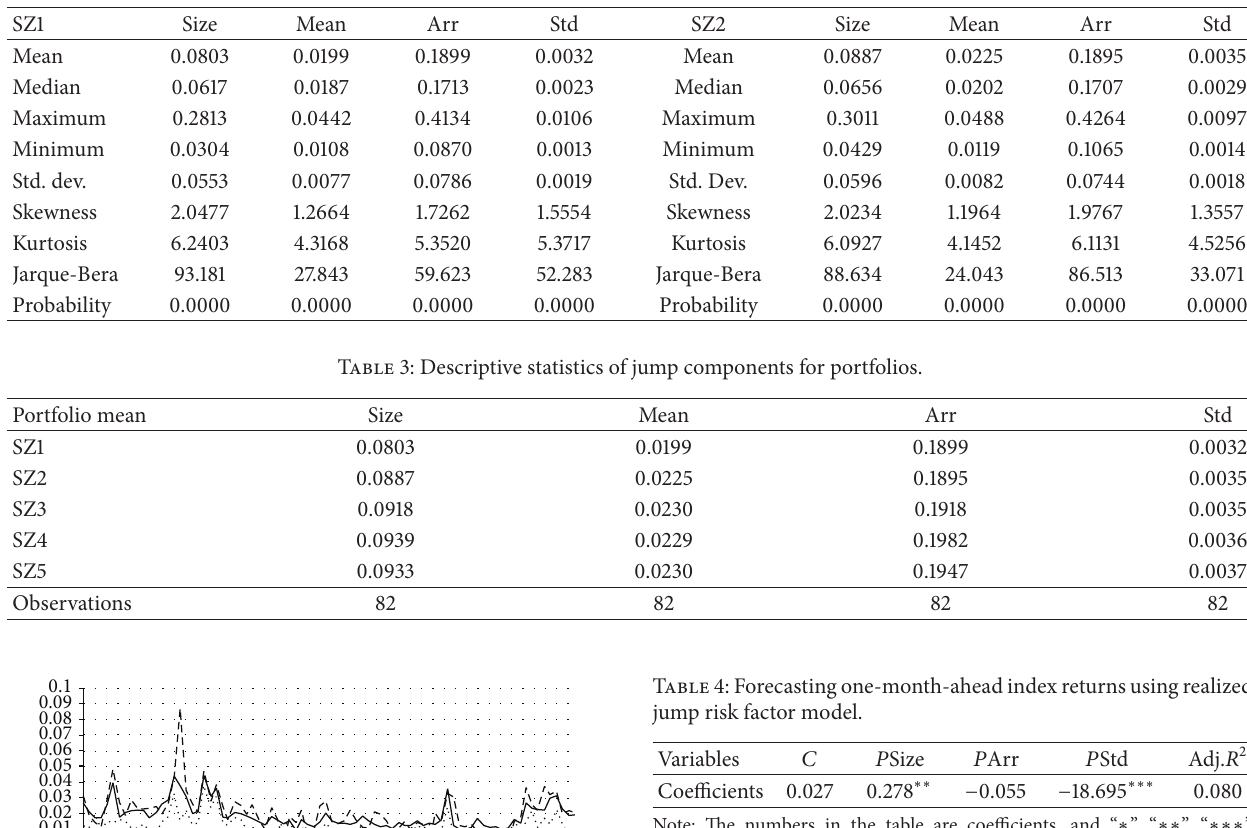
Table 2: Descriptive statistics of jump components for size 1 and size 2 portfolios.